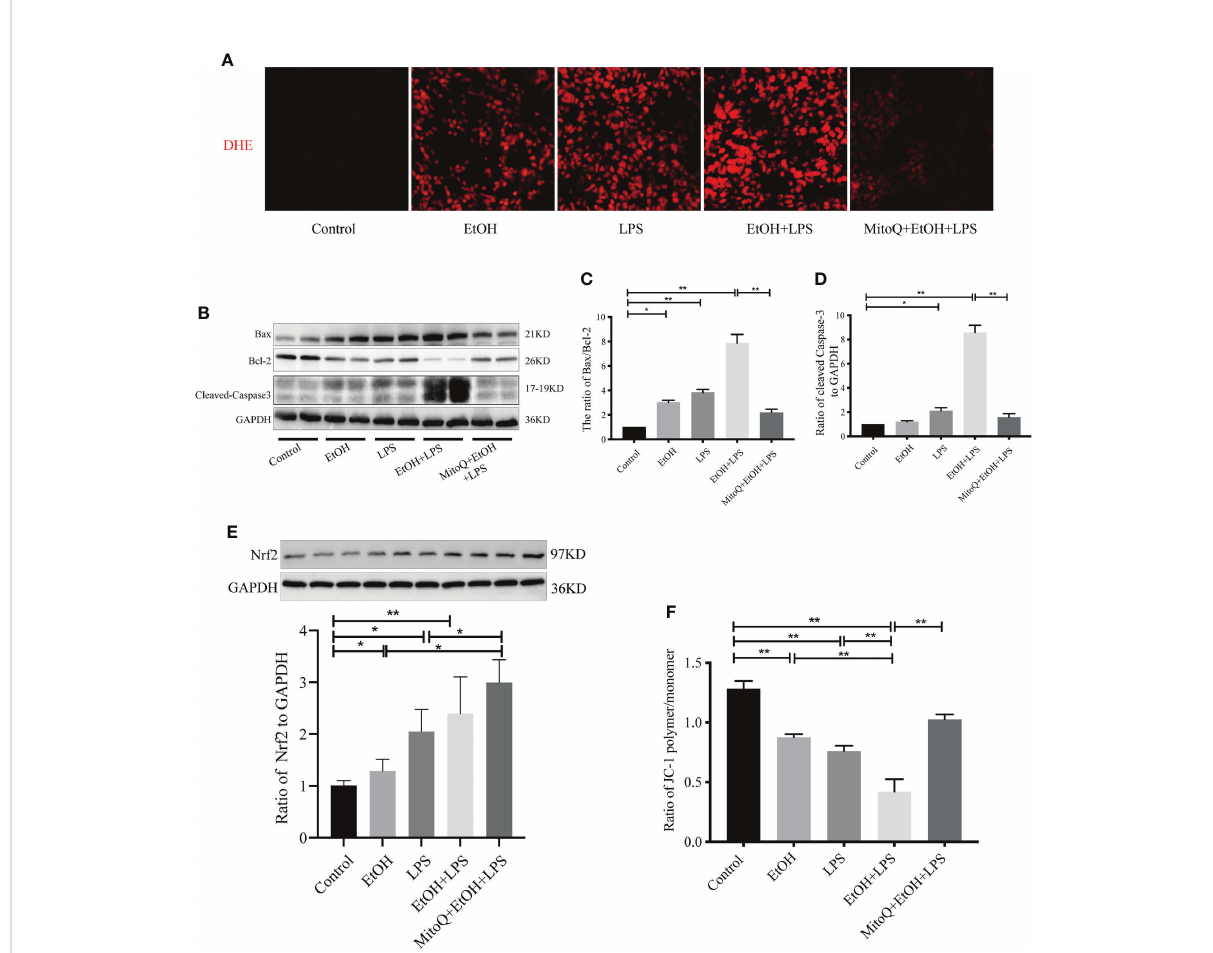
FIGURE 4 MitoQ decreased ethanol-LPS-induced ROS production and mitochondria injury. (A) DHE staining (red) was performed to assess ROS levels. (B) Protein expression of Bax, Bcl-2, and Cleaved Caspase-3 in lung tissue was detected by western blotting. (C) Relative expression of protein bax/bcl-2 was normalized against GAPDH. (D) Relative expression of protein Cleaved Caspase-3 was normalized against GAPDH. (E) Relative expression of protein Nrf2 was normalized against GAPDH. (F) Mitochondrial membrane potential ( DY m) was evaluated by the OD value of fl uorescence microplate and then calculated the ratio of polymer/monomer. All data were presented as mean ± SEM (n=6 in each group), *P < 0.05, **P <